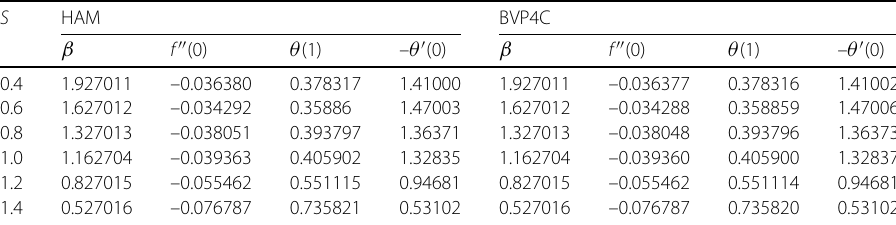
Table 10 Comparison of the values of β = Υ Mathematica package BVPh2.0 approximation and shooting method for the case β = 0.2, I 0 =